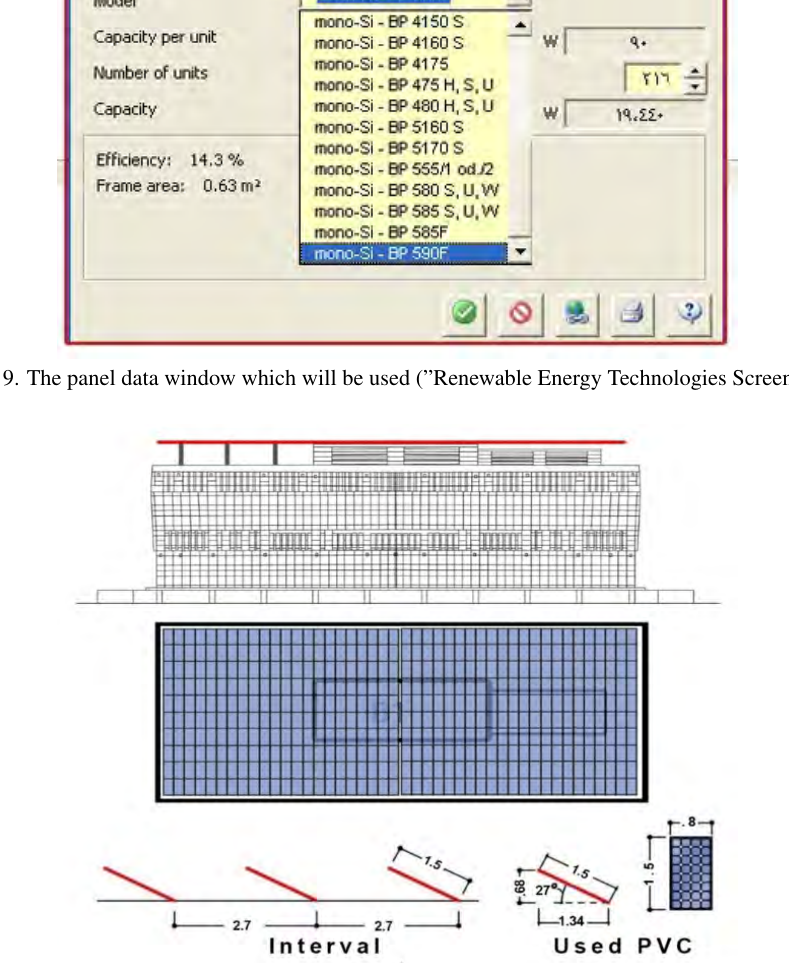
Figure 10. Distribution of photovoltaic matrices in astatic routing method and an open